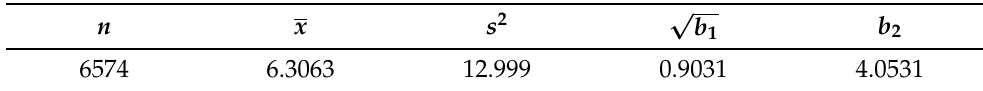
Table 2. Descriptive summaries for wind speeds